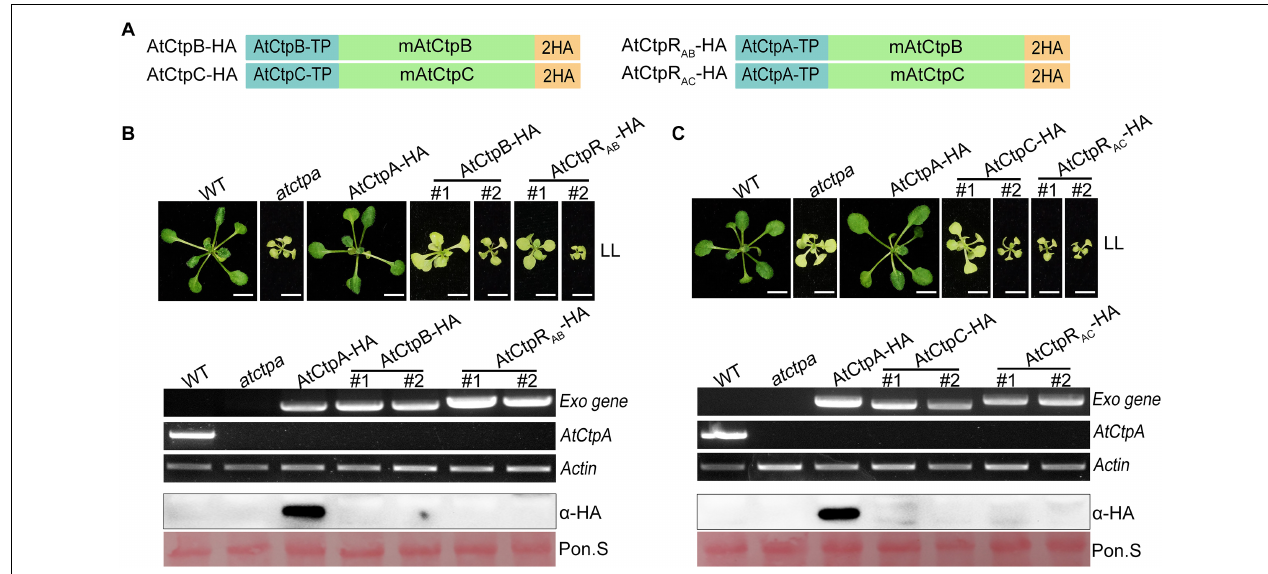
FIGURE 7 | The phenotype of atctpa plants carrying AtCtpB or AtCtpC driven by 35S promoter. (A) Schematic diagrams of AtCtpB-HA or AtCtpR AB - HA and AtCtpC-HA or AtCtpR AC - HA . AtCtpA-TP , AtCtpB-TP , and AtCtpC-TP are the chloroplast transit peptides of the corresponding AtCtp proteins; mAtCtpB and mAtCtpC represent the mature proteins; 2HA indicates a double hemagglutinin tag. (B,C) Ectopic expressions of AtCtpB-HA or AtCtpR AB -HA and AtCtpC-HA or AtCtpR AC -HA in the atctpa mutant. CaMV 35S promoter-driven AtCtpB-HA or AtCtpR AB -HA and AtCtpC-HA or AtCtpR AC -HA were transformed into the atctpa mutant through the Agrobacterium-mediated method. Upper panels in (B,C) the plants were grown on 1/2 MS with 1% sucrose under continuous low light (LL, 25 µ mol/s/m 2 ) for 3 weeks; #1 and #2 indicate two independent transgenic lines. Scale bars represent 0.5 cm. Lower panels in (B,C) expression of exogenous transgenes ( Exo ) in transgenic plants were examined at RNA (top three images) and protein (bottom two images) levels by semi qRT-PCR and immunoblot analysis. For semi qRT-PCR analysis, expressions of the endogenous AtCtpA gene in transgenic plants was used for confirming backgrounds, and expression of the housekeeping gene Actin 2 ( AT3G18780 ) was used as quantity control. For immunoblot analyses, the filters stained with Ponceau S (Pon. S) were used as loading